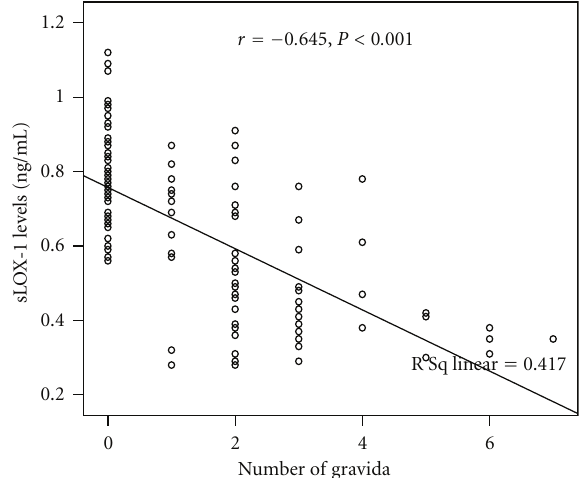
Figure 2: The correlation between sLOX-1 levels and number of gravida.